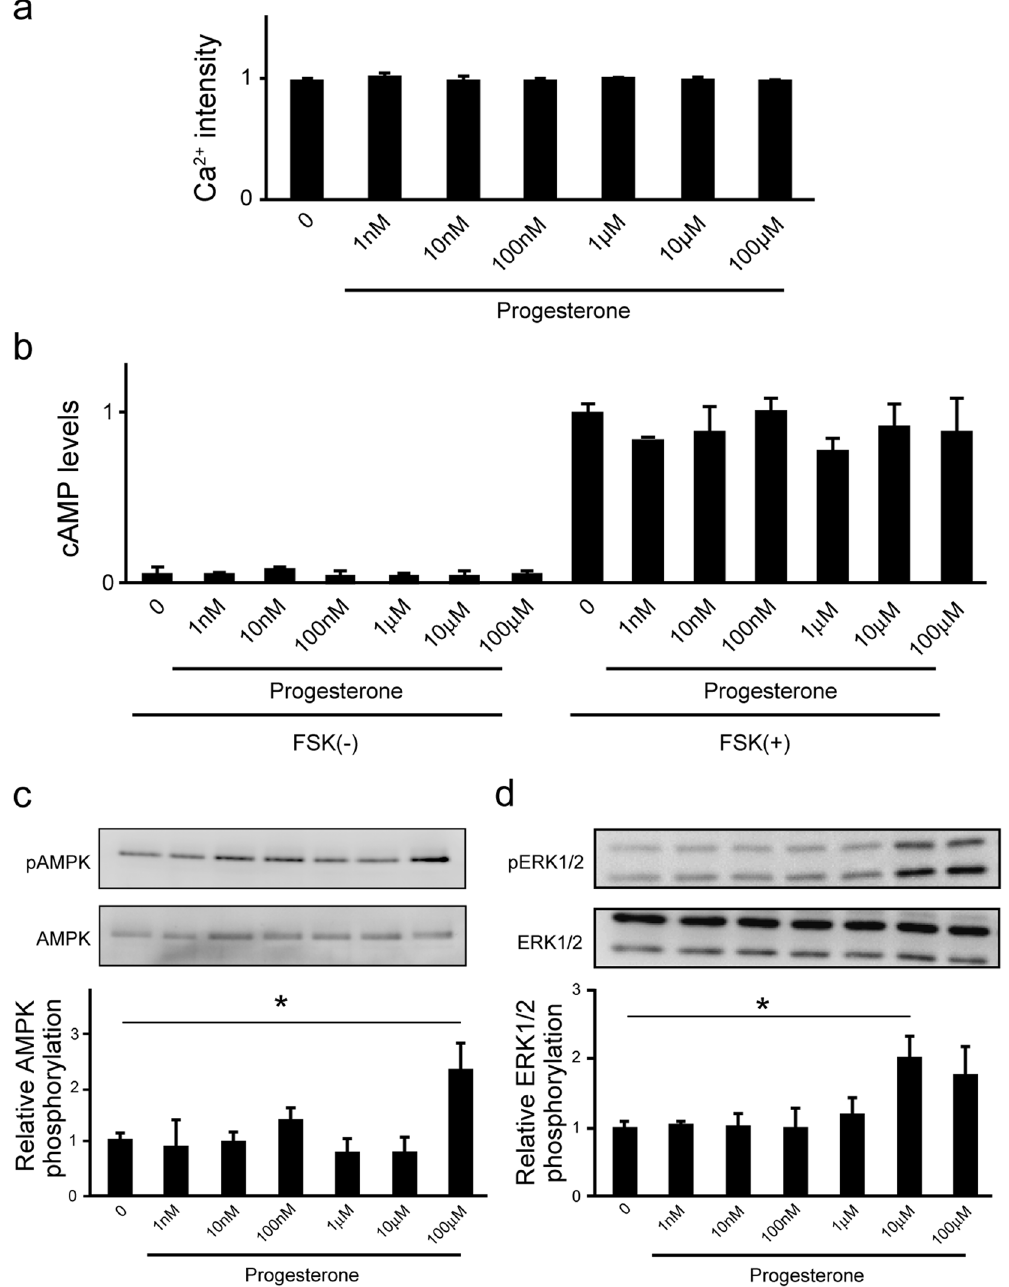
Figure 3. Progesterone promotes ERK phosphorylation via non-GPCR signaling in NGF-induced neuronal PC12 cells. ( a ) Mobilization of [Ca 2 + ] i induced by progesterone was monitored in PC12 cells, and data are presented as relative Ca 2 + intensity. After 2 h in culture, cells were treated with NGF (50 ng/mL) and further cultured in DMEM containing 1% FBS for 24 h. (n = 3). ( b ) cAMP levels in response to progesterone treatment in PC12 cells. After 24 h in culture, NGF-induced PC12 cells pre-cultured with IBMX for 30 min were cultured in the presence of progesterone for 10 min. The cAMP levels in the cells were determined by using a cAMP EIA kit. (n = 3). ( c ) Effects of progesterone on AMPK phosphorylation in PC12 cells. After 24 h of culture, NGF- induced neuronal PC12 cells were further cultured for 3 h in serum-free DMEM. The cells were cultured in the presence of progesterone for 10 min. AMPK and its phosphorylated form were detected by western blotting with specific antibodies. (n = 5) ( d ) Agonistic effects of progesterone on ERK1/2 phosphorylation in PC12 cells. After 24 h of culture, NGF-induced neuronal PC12 cells were further cultured for 3 h in serum-free DMEM. The cells were cultured in the presence of progesterone for 10 min. ERK1/2 and its phosphorylated form were detected by western blotting with specific antibodies. (n = 3). Statistical analysis was performed by using one-way analysis of variance followed by Tukey-Kramer’s post hoc test, compared with control. FSK: Forskolin. Results are presented as means ± S.E.M. of independent